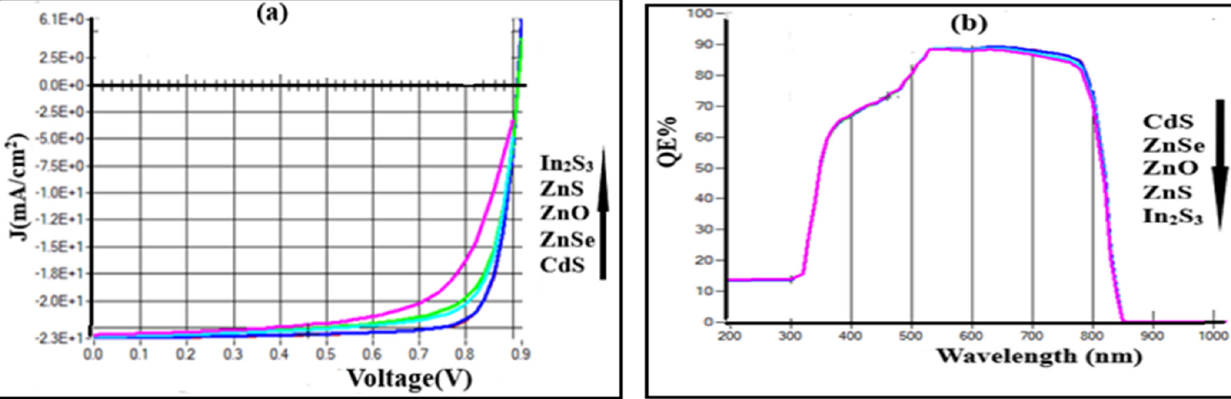
Figure 4. The simulated electrical performance parameters as a function of the acceptor charge carrier concentration ( N A ): ( a ) V OC , ( b ) J SC, ( c ) FF , ( d ) η %. 3.2. Modelling and Optimization of CdTe Absorber Layer Doping Level The absorber (CdTe) acceptor carrier concentration ( N A ) changes in the ranges of 2 (cid:3400) 10 12 cm -3 to 2 (cid:3400) 10 17 cm -3 , as shown in Table 5. The main goal of this study is to obtain a carrier concentration ( N A ) of the CdTe absorber layer without losses in cell performance. As consequence, low cost can be accomplished by reducing the amount of expensive ma ‐ terials that is used. Table 5. Effectiveness of the acceptor carrier concentration ( N A ) on the electrical cell performance parameters at T = 300 K.